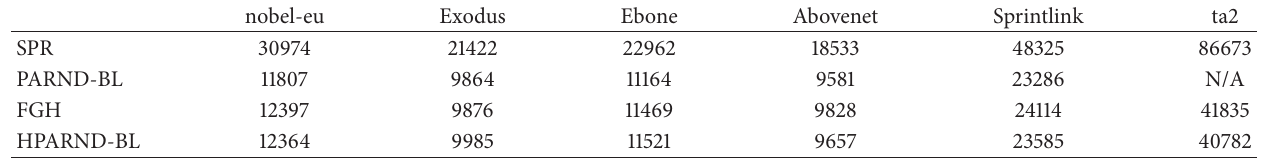
Table 6: Power consumption (W) versus topology—cubic curve, 𝑃 𝐶 V = 200 W. nobel-eu Exodus Ebone Abovenet